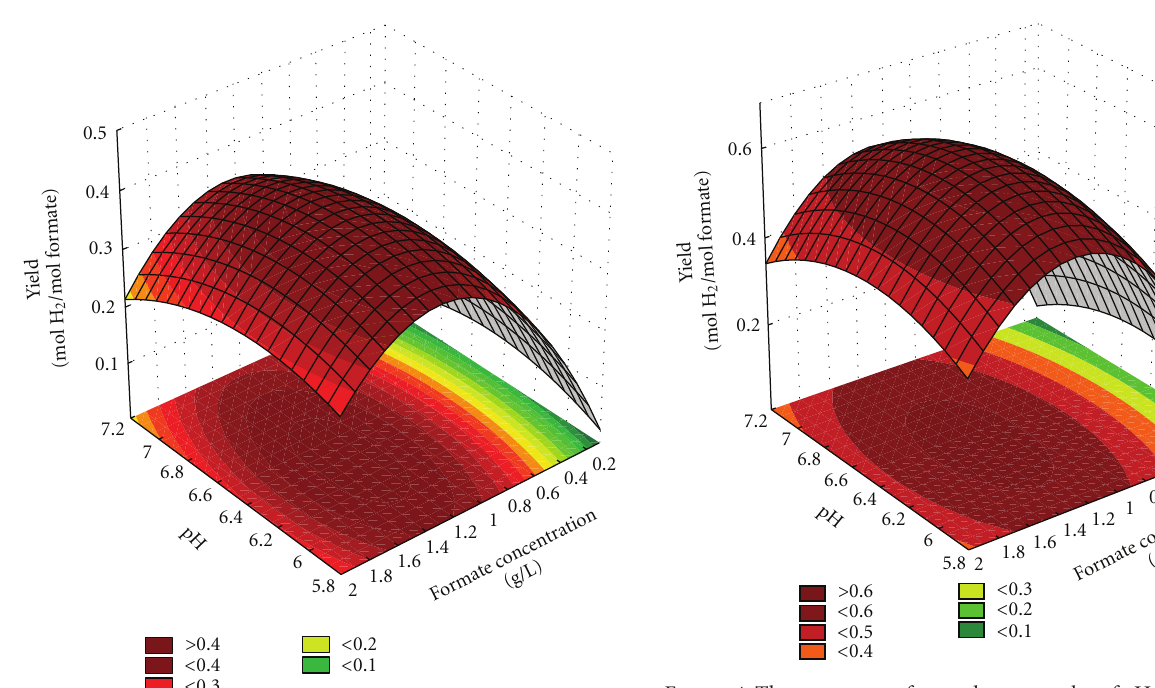
Figure 4: The response surface and contour plot of pH and formate concentration on hydrogen yield for E. coli (DJT